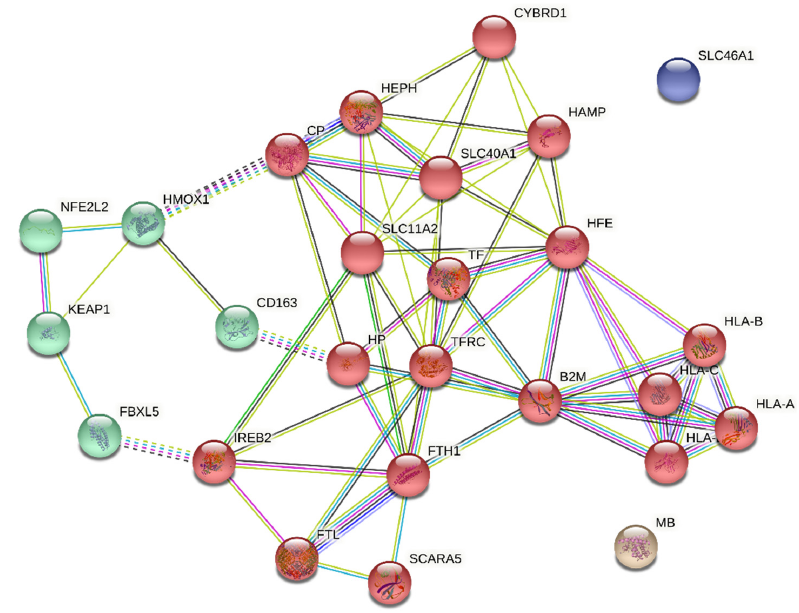
Figure 5. Protein-protein interactions network of iron metabolism and the immune system. The colored nodes represent the results of the Markov cluster algorithm to group proteins in two main biological functions: presentation of peptide antigens to the immune system (red) and ubiquitination, endocytosis, and degradation processes of proteins related to Fe metabolism in immune cells (e.g., macrophages) (green). The colors of interactions correspond to: known from curated databases (cyan), experimentally determined (purple); predicted interactions based on gene neighborhood (green), gene fusions (red), and gene co-occurrence (dark blue); and others, such as text-mining (yellow), co-expression (black), and protein homology (light blue). The input proteins were: CD163, scavenger receptor cysteine-rich type 1 protein M130; CP, ceruloplasmin; CYBRD1, cytochrome b reductase 1; FTH1, ferritin heavy chain; FTL, ferritin light chain; HAMP, hepcidin; HEPH, hephaestin; HMOX1, heme oxygenase 1; IREB2, iron-responsive element-binding protein 2; MB, myoglobin; SCARA5, scavenger receptor class A member 5; SLC11A2, natural resistance-associated macrophage protein 2; SLC40A1, solute carrier family 40 member 1; SLC46A1, proton-coupled folate transporter; TF, transferrin; TFRC, transferrin receptor protein 1. The network is available at https://version-11-0b.string-db.org/cgi/network?networkId=b1HF4feAW2Nr (accessed in 17 June 2021).